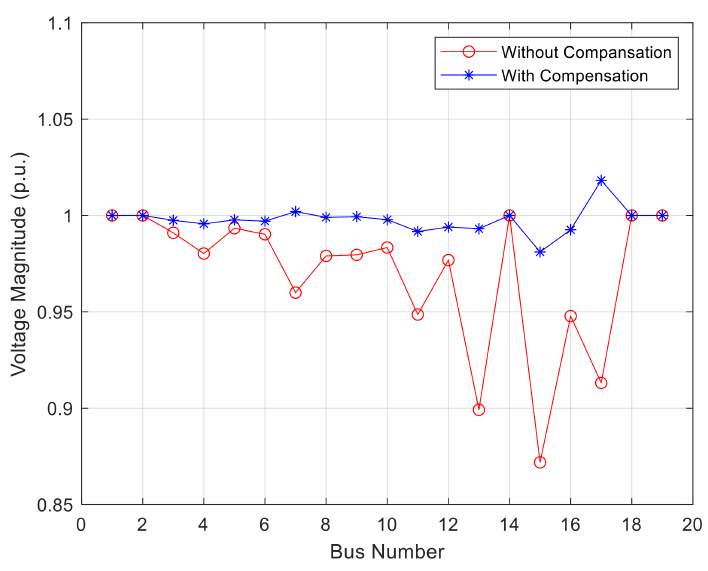
Figure 8. Comparison of voltage profile before and after case 4